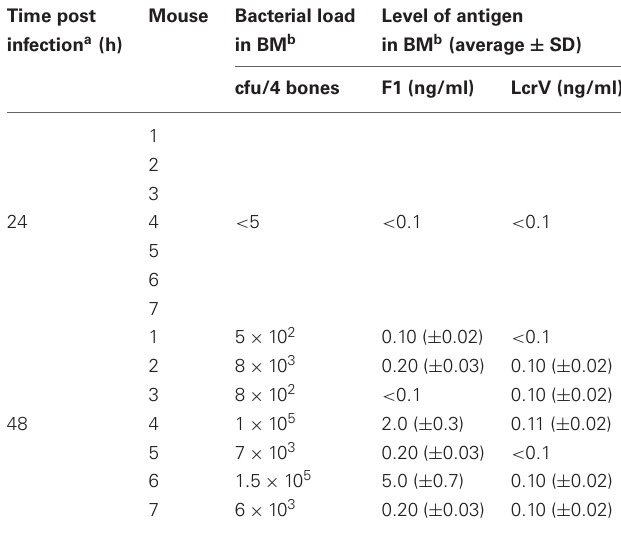
Table 2 | Determination of soluble LcrV and F1 proteins in BM of mice in a model of pneumonic